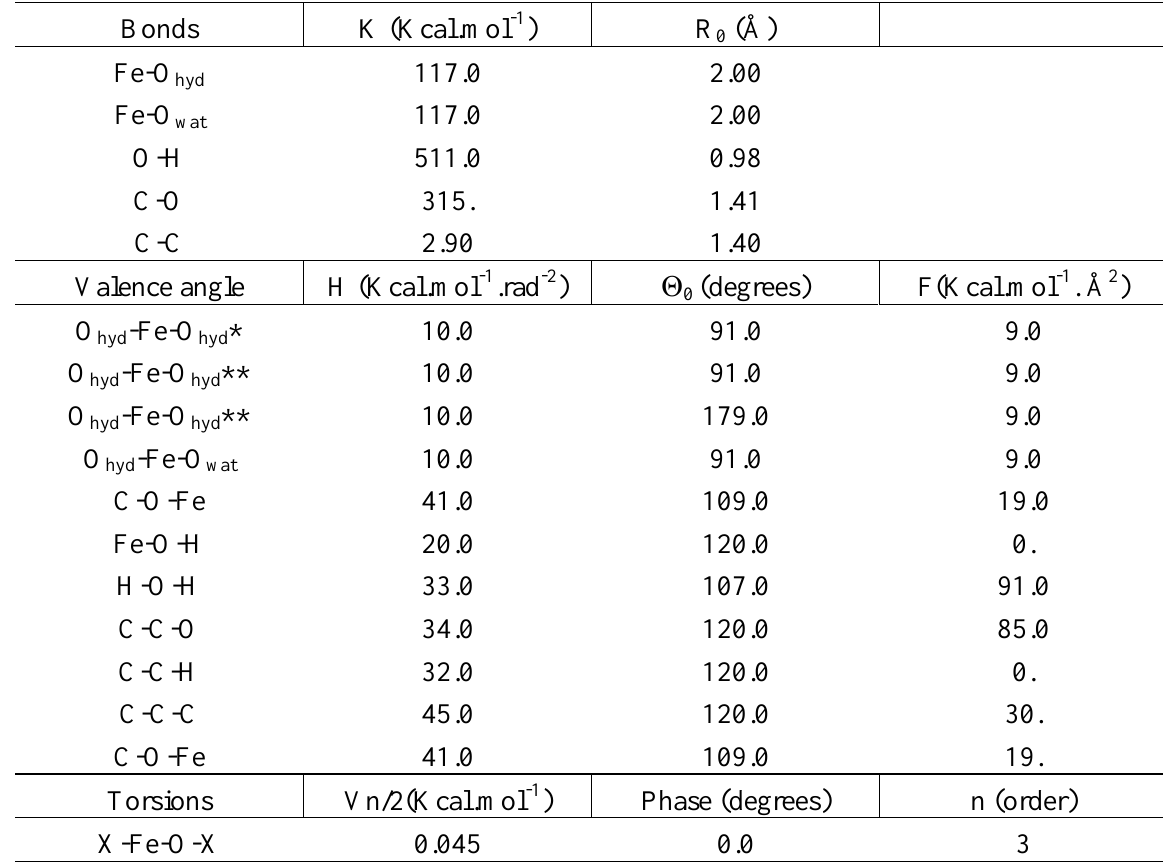
O) ] 3+ and [Fe(Cat) 2 6